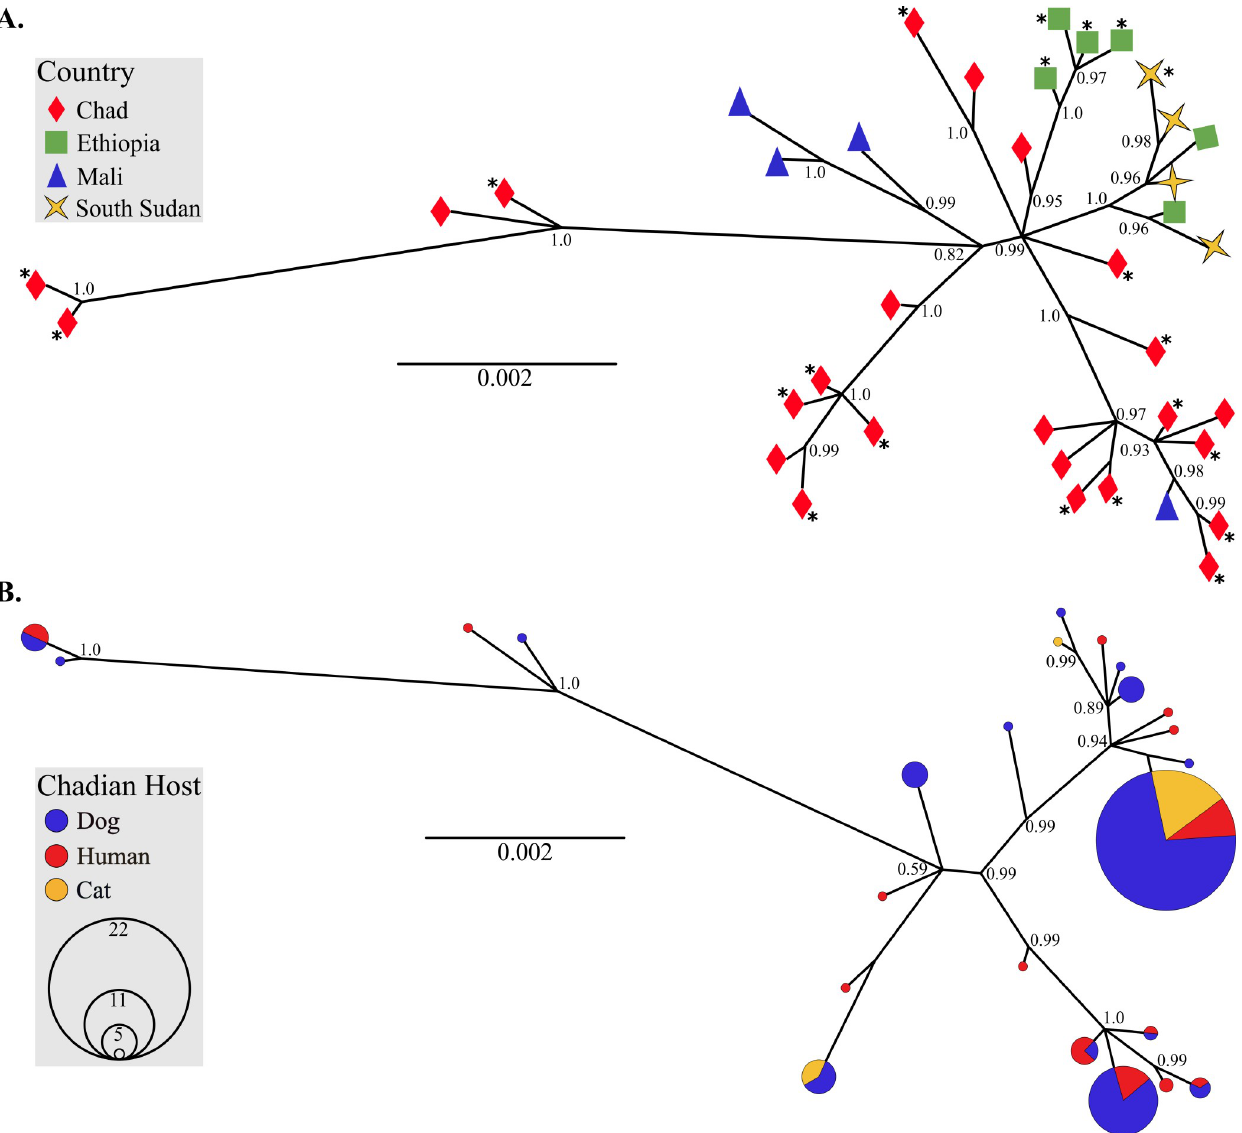
Fig 3. Phylogenies of mitochondrial lineages illustrate that African D . medinensis are a single species. (A) Genealogical relationship among unique D . medinensis haplotypes (concatenated cytB - cox3 - nd3-nd5 )from the four remaining endemic countries in Africa. Color and shape of tips indicate country of origin. Haplotypes where at least one parasite was collected from a non-human host are denoted with asterisks ( � ). (B) Relationship among unique D . medinensis haplotypes from Chad only. Circle size reflects prevalence of each haplotype in the Chadian population (smallest circles = 1) and color indicates the definitive host from which parasites were collected. Trees were inferred in MrBayes v3.2.6 [36] with two independent MCMC analyses of 1 million generations each. Posterior probabilities are indicated at branch